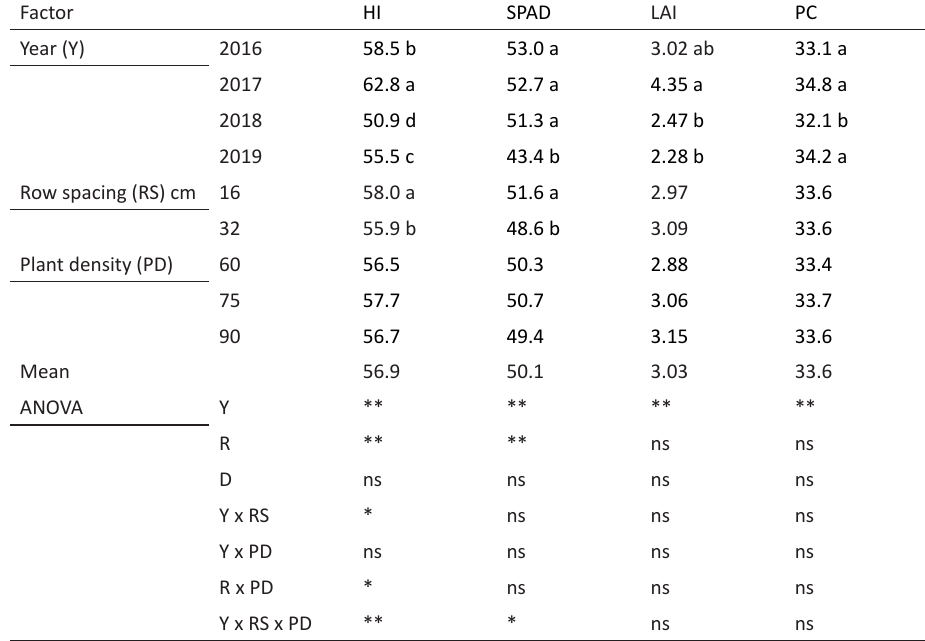
Table 7. HI, SPAD, LAI and PC values for white lupin depending of row spacing and plant density in 2016–2019 Factor HI SPAD LAI